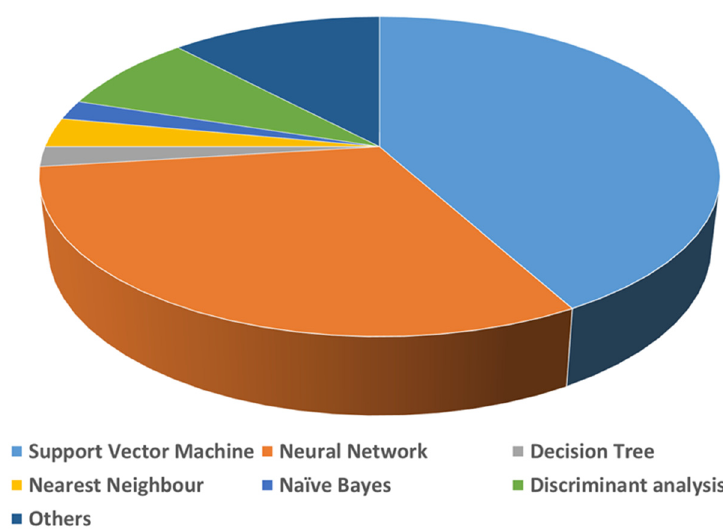
Figure 3. Use of various AI methods in medical applications. Table 1. Comparison of applications along with advantages and disadvantages of SVMs, NNs and other common AI algorithms used in biomedical